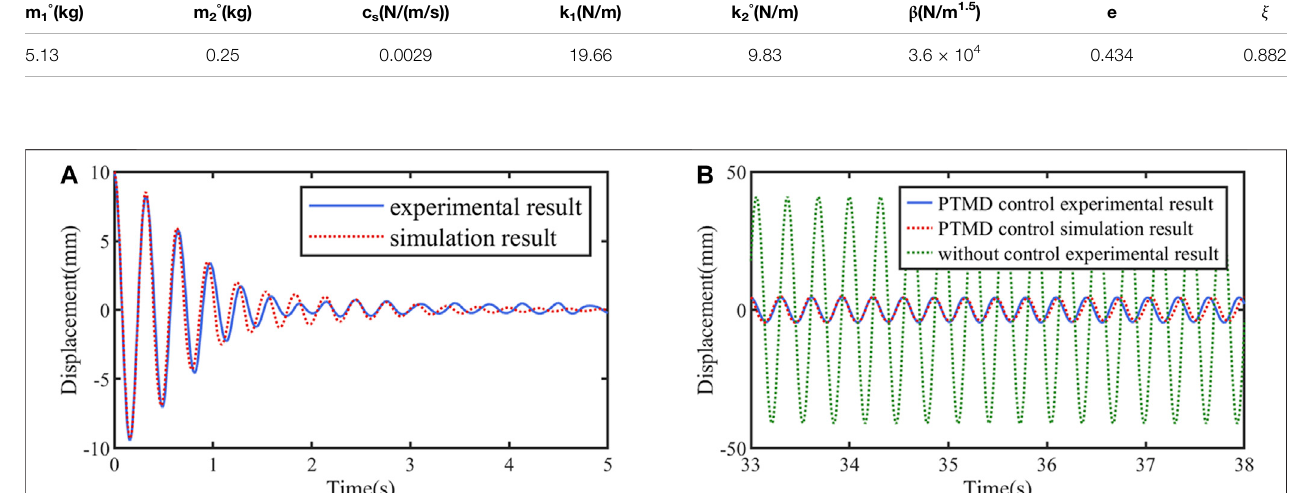
FIGURE 13 | Simulation results: (A) Free vibration case; (B) Forced resonant vibration